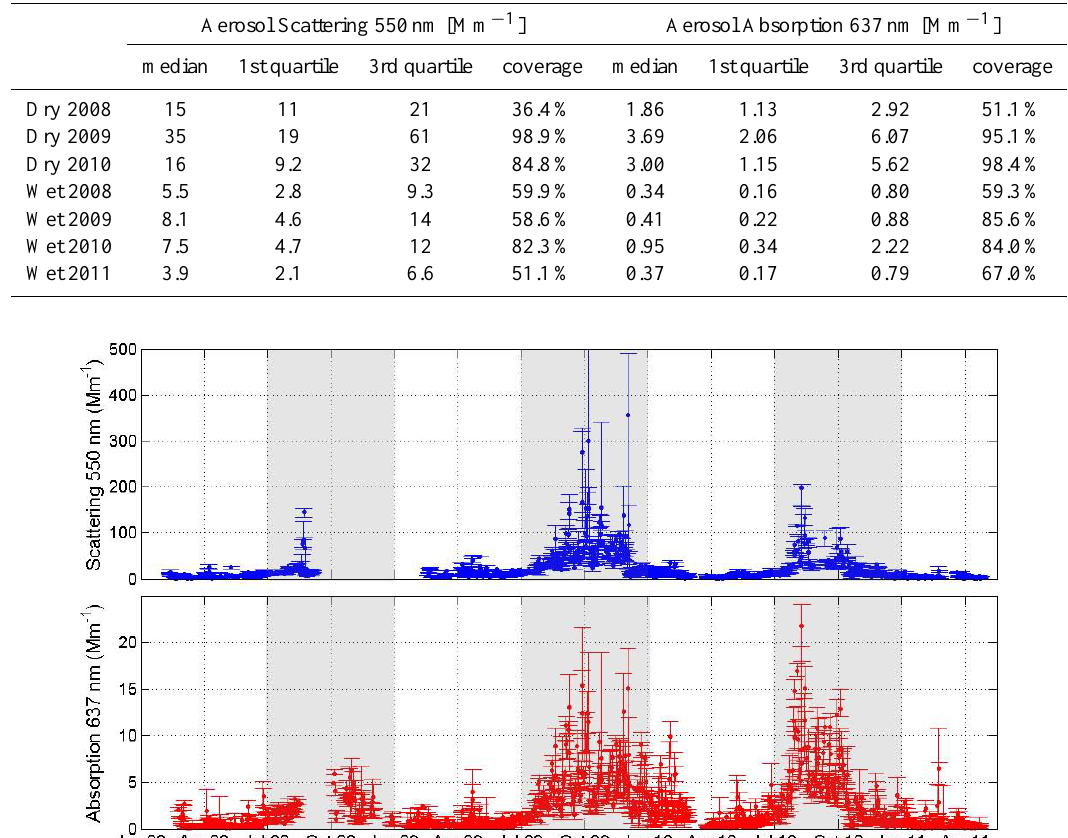
Fig. 4. Daily medians of aerosol particle scattering coefficients at 550nm (a) and of aerosol particle absorption coefficients at 637nm (b) , from February 2008 to May 2011. Error bars represent first and third quartiles. Shaded areas represent the dry season